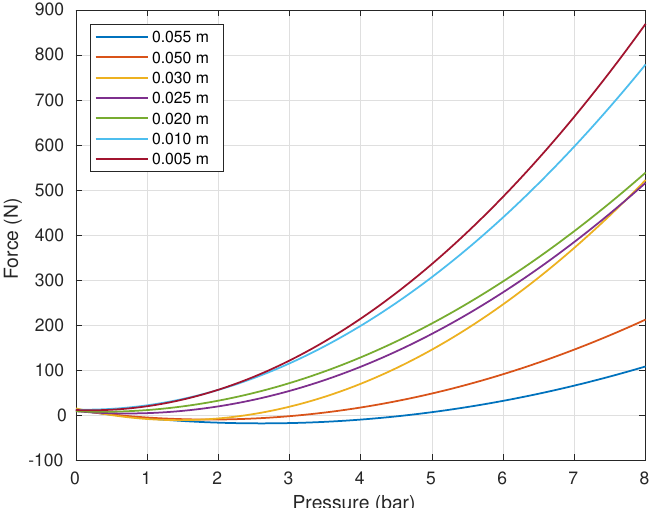
Figure 4. Results of the stretch force with different applied pressures under isometric constraint.